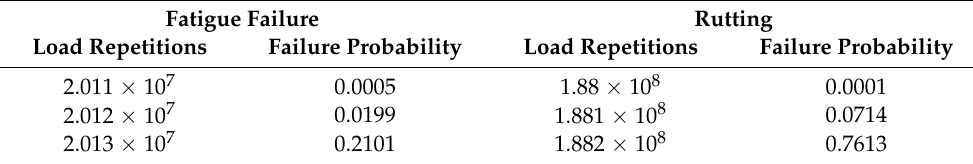
Figure 13. Results of the probability density distributions of cumulative damage for ( a ) fatigue fail- and ( b ) rutting after repeated random loads. ure and ( b ) rutting after repeated random loads. Table 7. Failure probability of the pavement after a given number of load repetitions. Table 7. Failure probability of the pavement after a given number of load